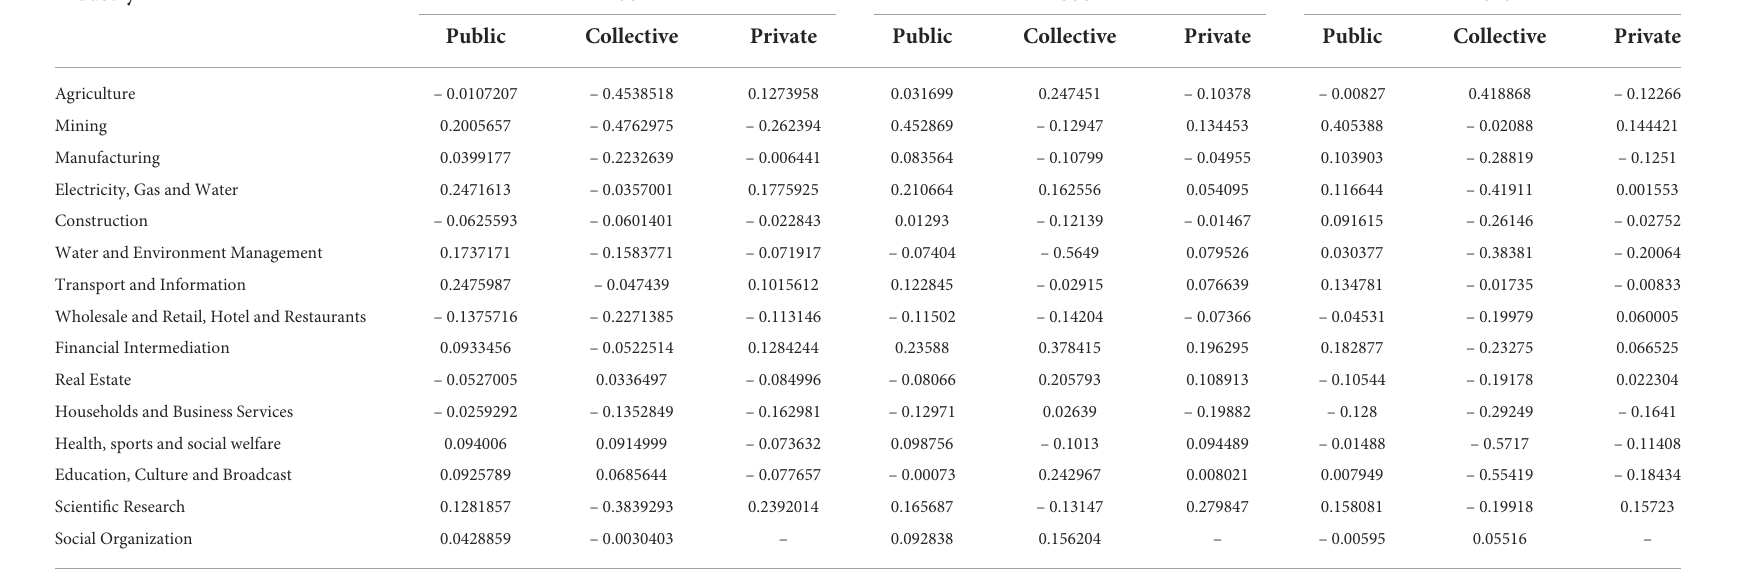
TABLE 5 Adjusted wage differentials